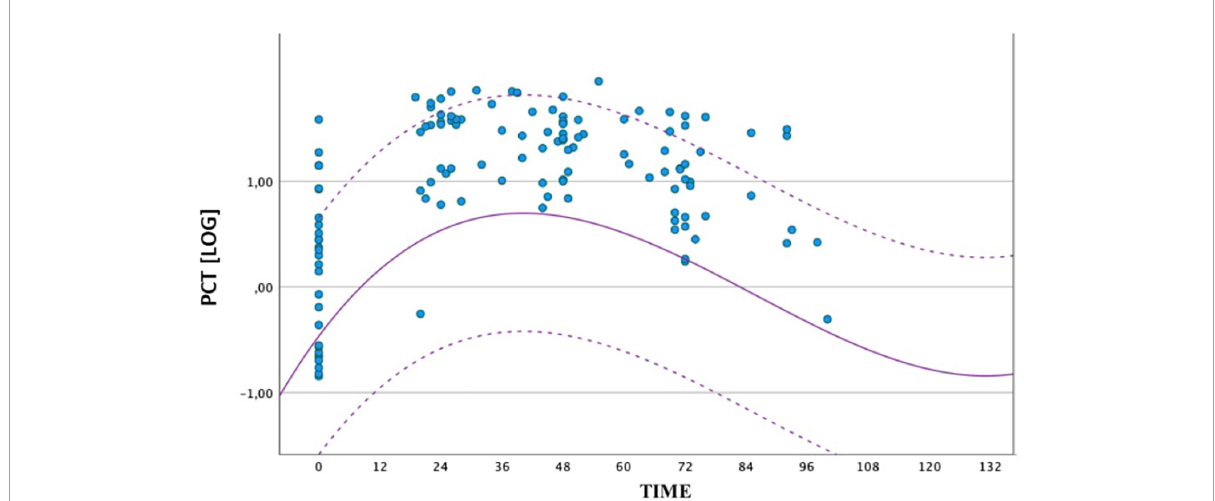
FIGURE2 Comparison between the distribution of PCT values obtained by the group of septic newborns between birth and 72 ± 4 h of life. The circles represent the individual logPCT values of septic infants, while the dashed curves represent the reference range of non-septic infants. The logarithmic scale of the PCT values is shown on the ordinate axis.